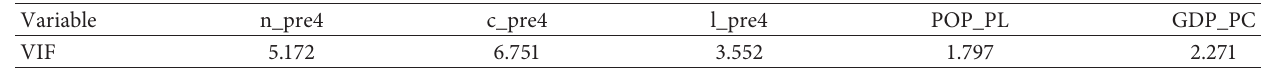
Table 6: The results of multicollinearity test.